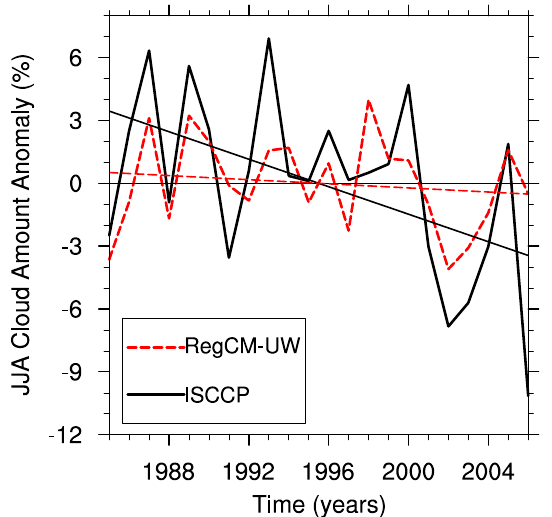
Fig. 13. Interannual variations in JJA-average low cloud frac- tion anomaly (the mean is removed, and the variability is pre- served). The solid, black curve shows data from ISCCP; and the dashed, red curve shows output from RegCM-UW. Regression lines are also drawn through both curves: ISCCP declines at a rate of − 3 ± 1%decade − 1 , and RegCM-UW declines at a rate of − 0 . 5 ± 0 . 8%decade − 1 . The correlation between the two time- series is r = 0 . 67, which is statistically significant above the 99.9% confidence